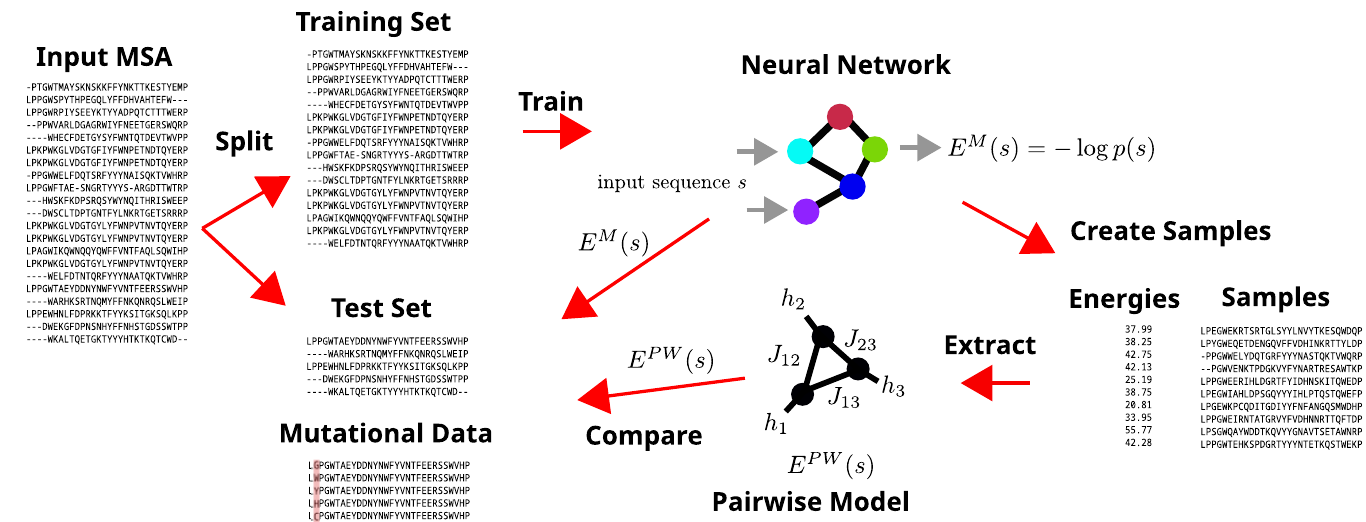
Fig 1. Pipeline. An overview of our train and test pipeline. Given an input MSA, we remove duplicated sequences and split into training and test set with a ratio of 9:1. We then train neural network models on the training set. After creating samples (either from the distribution induced by the neural network itself or from another distribution), we calculate the energy (negative log probability) of these samples from the neural network. We then use the samples and energies to extract a pairwise model (and also an independent model) and compare the original neural network model with the extracted in terms of their energies and their performance in mutational effect